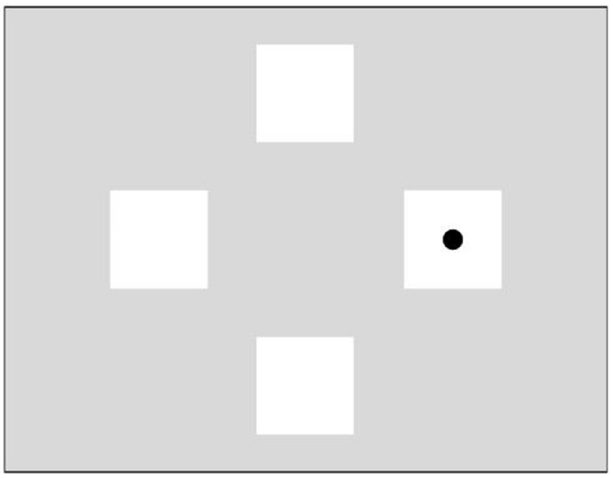
Fig 1. Example of ocular activated serial reaction time task target